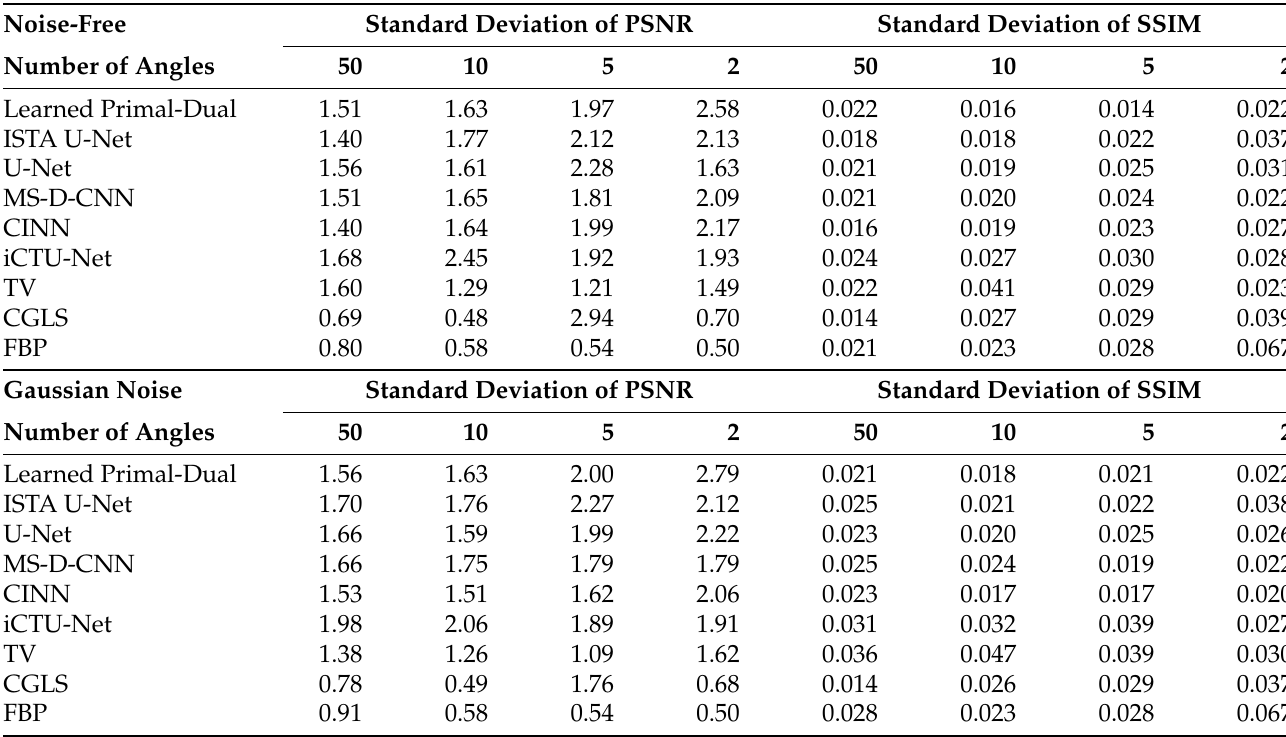
Table A3. Standard deviation of PSNR and SSIM (adapted to the data range of each ground truth image) for the different noise settings on the 100 selected Apple CT test